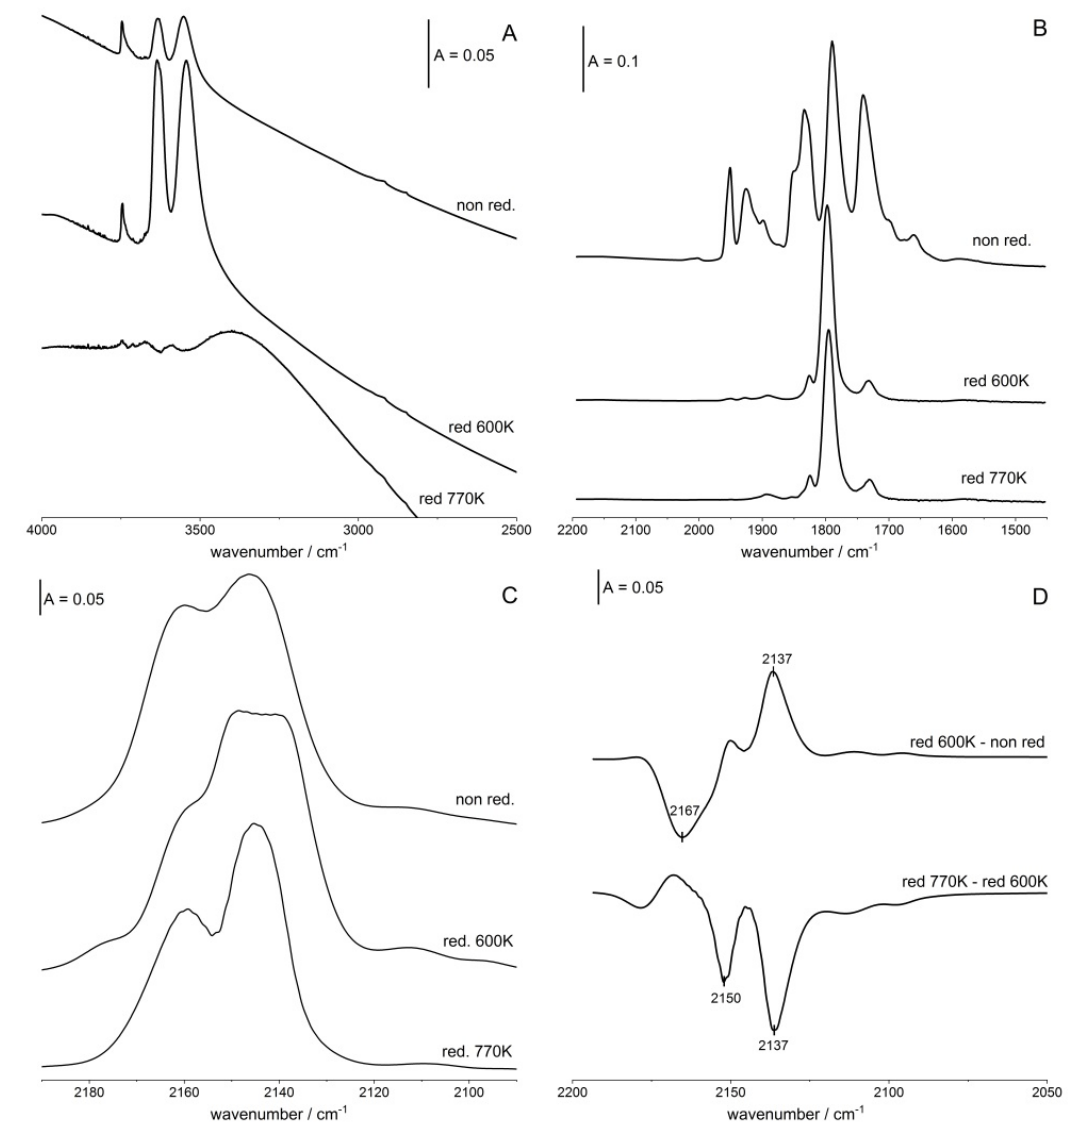
Figure 3. ( A ) The spectra of OH groups in zeolite CuY non-reduced and in zeolite reduced with hydrogen at 600 and 770 K. ( B , C ) The spectra of NO ( B ) and CO ( C ) sorbed at 170 K (NO) and room temperature (CO) in zeolite CuY non-reduced and reduced at 600 and 770 K, ( D ) Difference spectra: differences between the spectra recorded upon the reduction at various